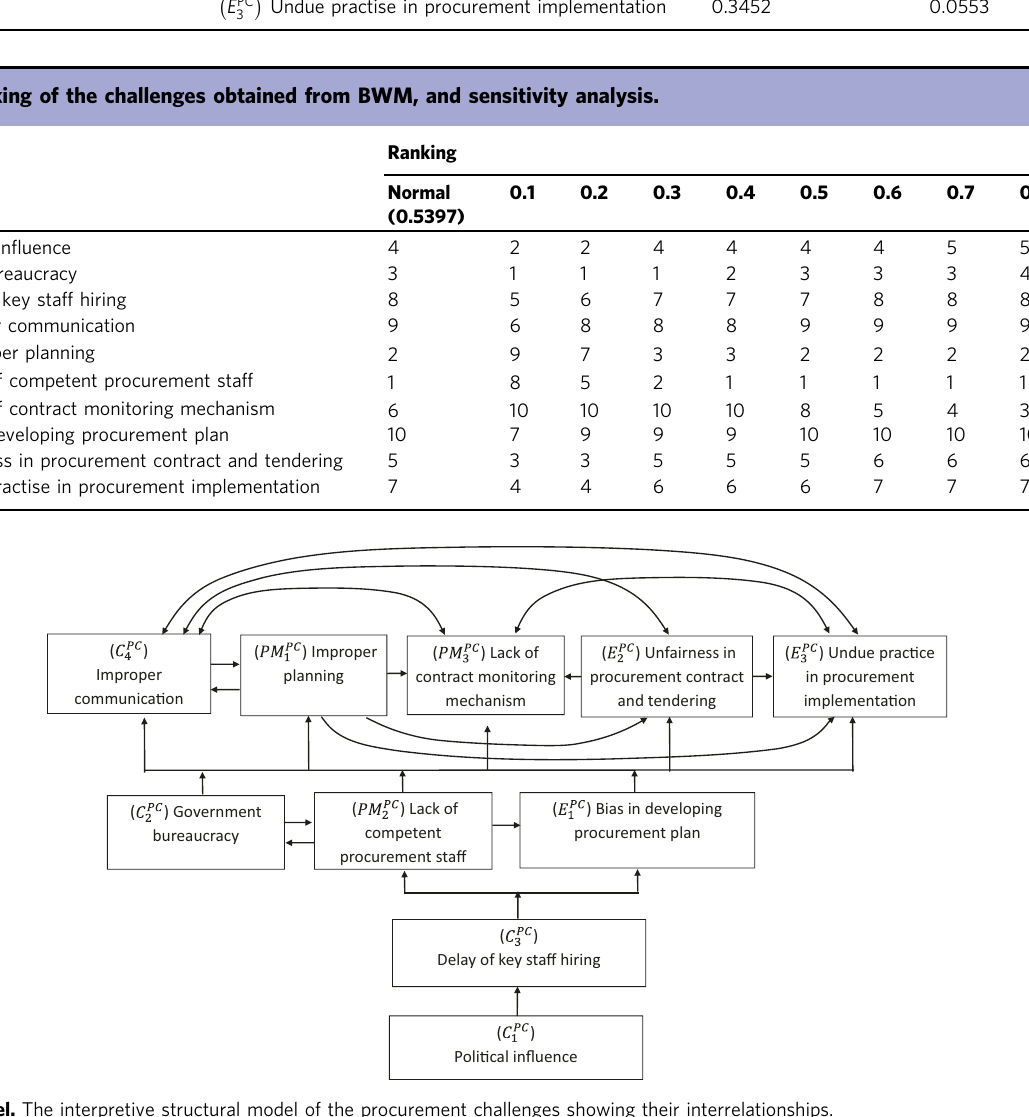
Fig. 5 ISM model. The interpretive structural model of the procurement challenges showing their